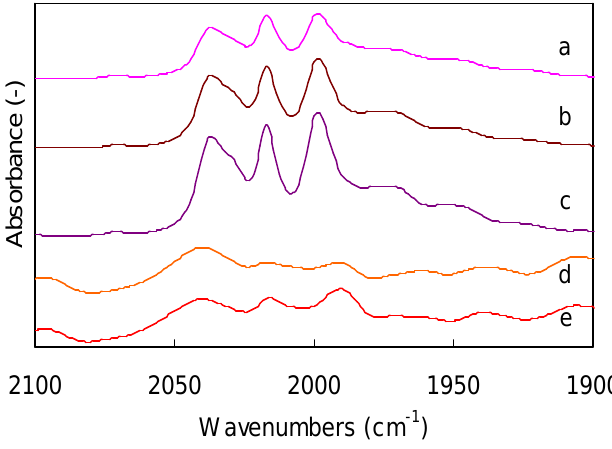
Figure 6. FTIR spectra of catalytically active species prepared in NMP at different CO pressures. Ru (CO) + LiCl in NMP at (a) CO 3 12 (c) CO 1 MPa, H 1 MPa. (d) Ru 2 2